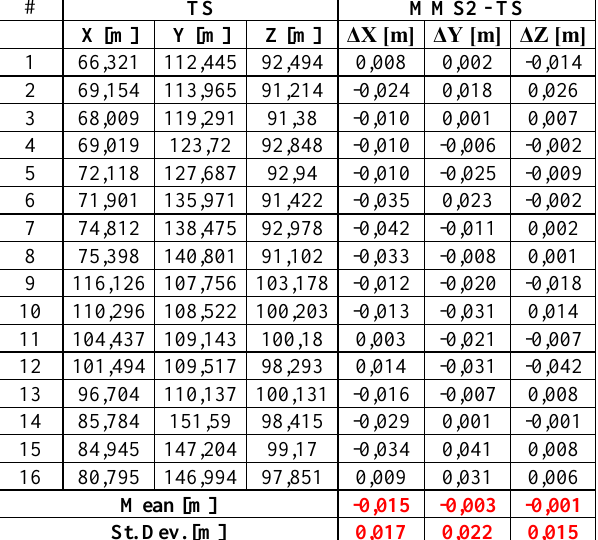
Table 7. 3D coordinate residuals after the second adjustment